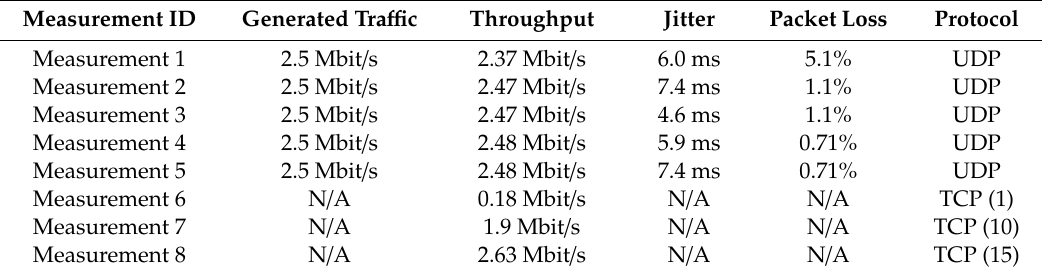
Table 2. Iperf3 measurements of satellite link parameters.